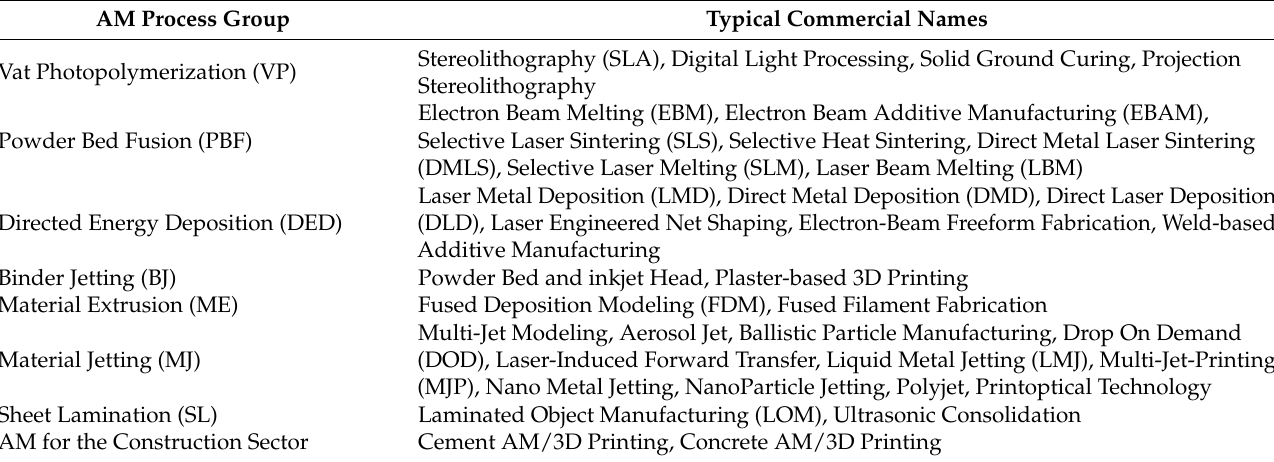
Table 1. Classification of additive manufacturing (AM) processes (according to